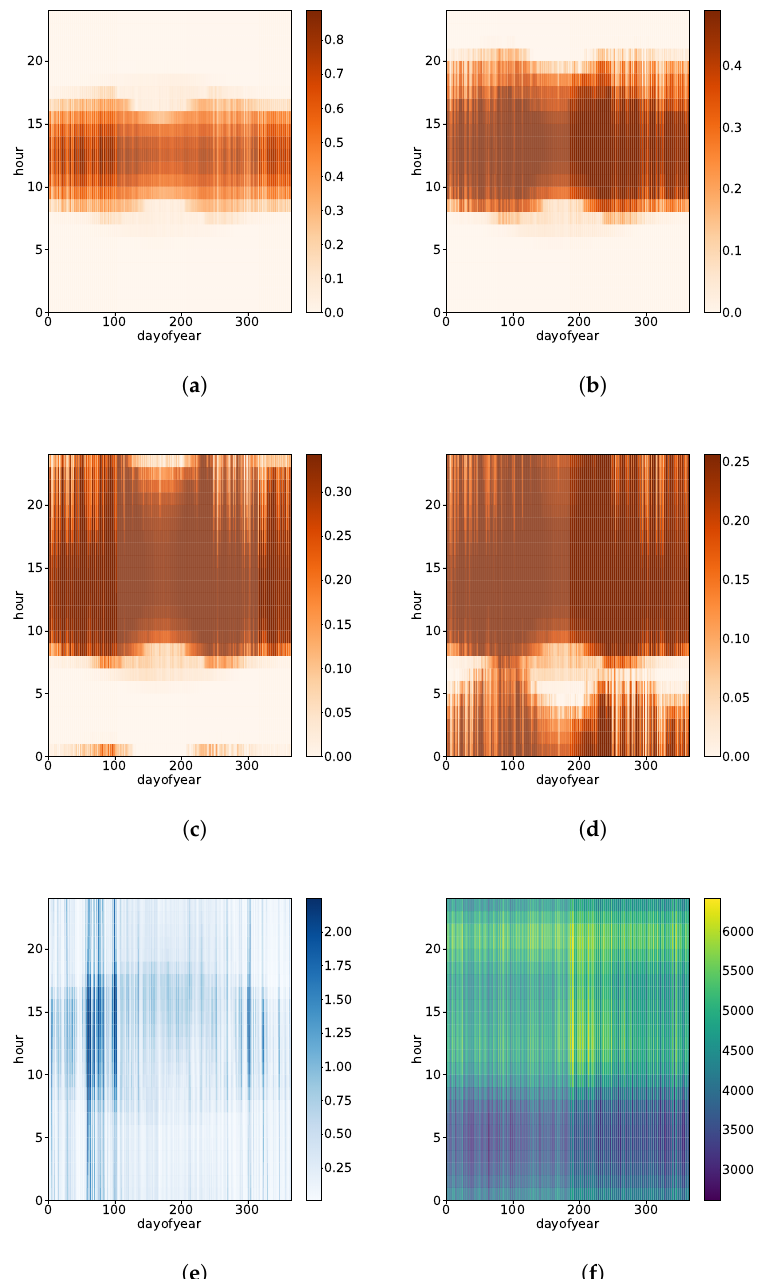
Figure 7. Heatmap of the national daily (ordinate) and seasonal (abscissa) variability of the predicted capacity factors and demand (MW): PV without storage (ILR1) ( a ), PV-BES ILR2 ( b ), PV-BES ILR3 ( c ), PV-BES ILR4 ( d ), Wind ( e ), Demand ( f ). ILR > 1: with increasing levels of storage. The variation over time is shown in colour by intensity in the colour